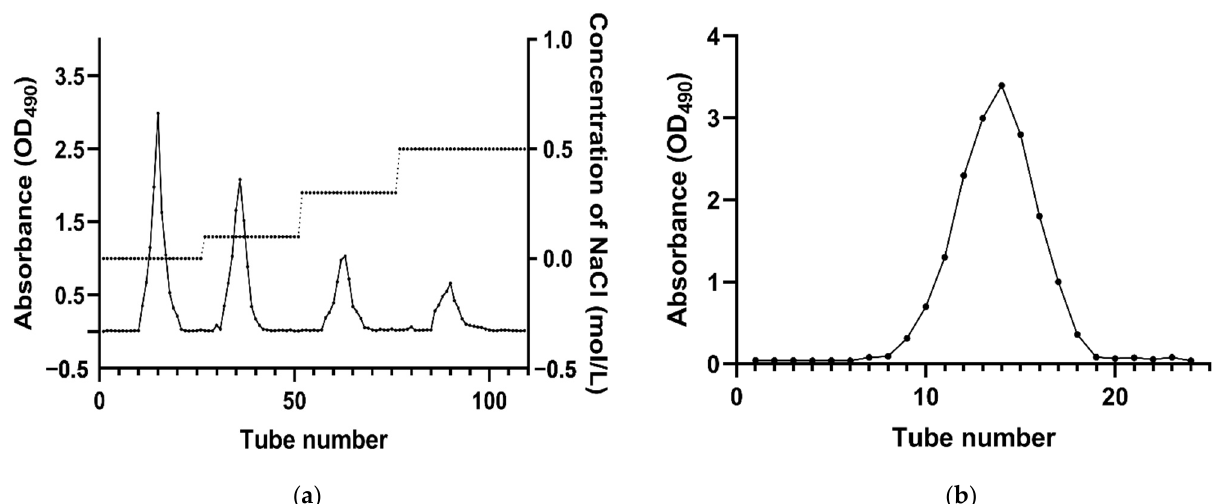
Figure 1. Elution curves of crude polysaccharides from O. fimbriata on DEAE cellulose-52 column ( a ) and Sephadex G-75 column ( b ).